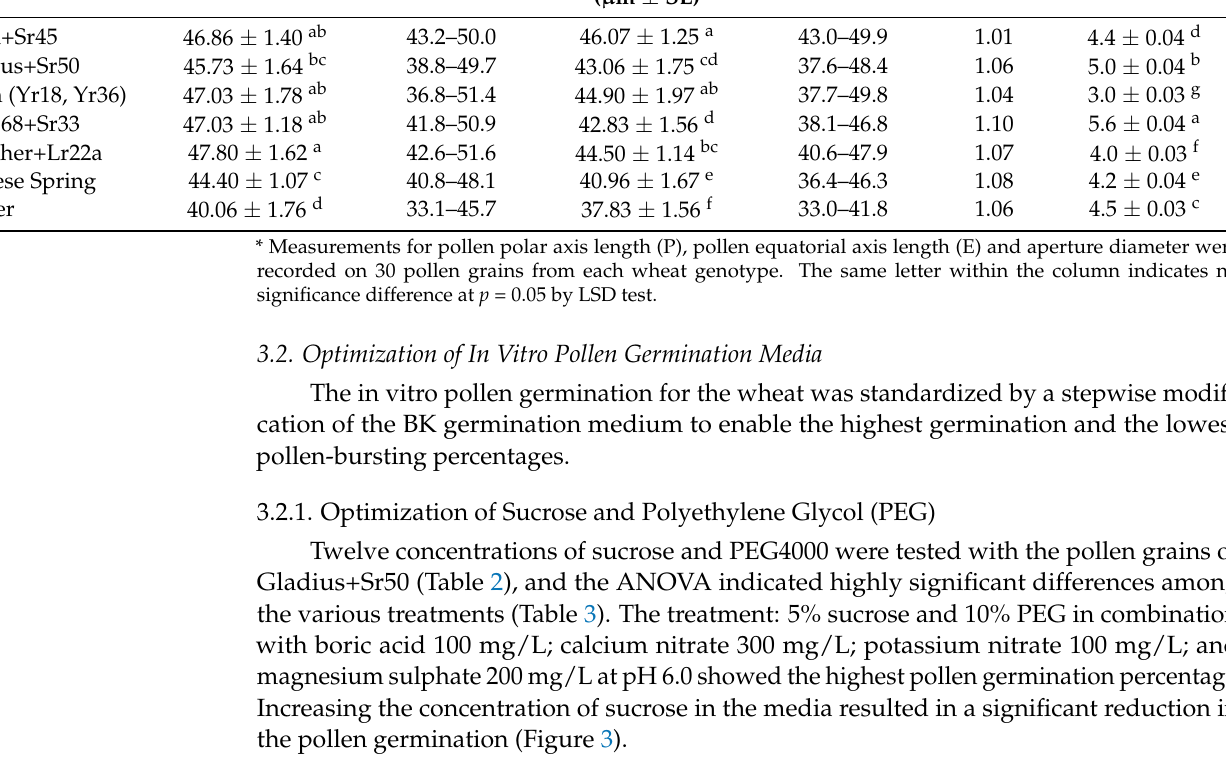
Table 2. The combinations of sucrose and PEG used to modify the composition of the Brewbaker and Kwack (BK) basal